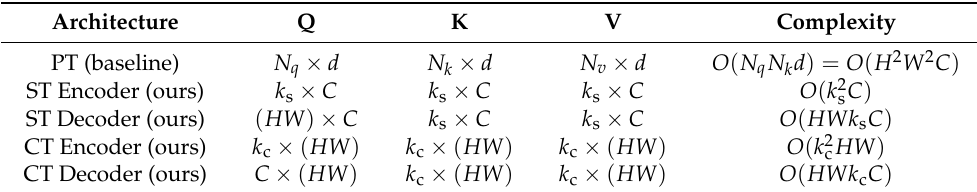
Table 3. Computational complexity of different network architectures. PT : Plain Transformer layer. ST : Spatial Transformer in SST. CT : Channel Transformer in SST. Q , K , V are the query matrix, key matrix and value matrix in transformer layer respectively. Values of Q , K , V in the table are their dimensions. Complexity means the memory consumption. Let N q , N k , N v be the number of query, key, and value elements in the plain transformer, respectively. We have the following observations in general. N k = N v = N q for self-attention, and N k = N v (cid:54) = N q for